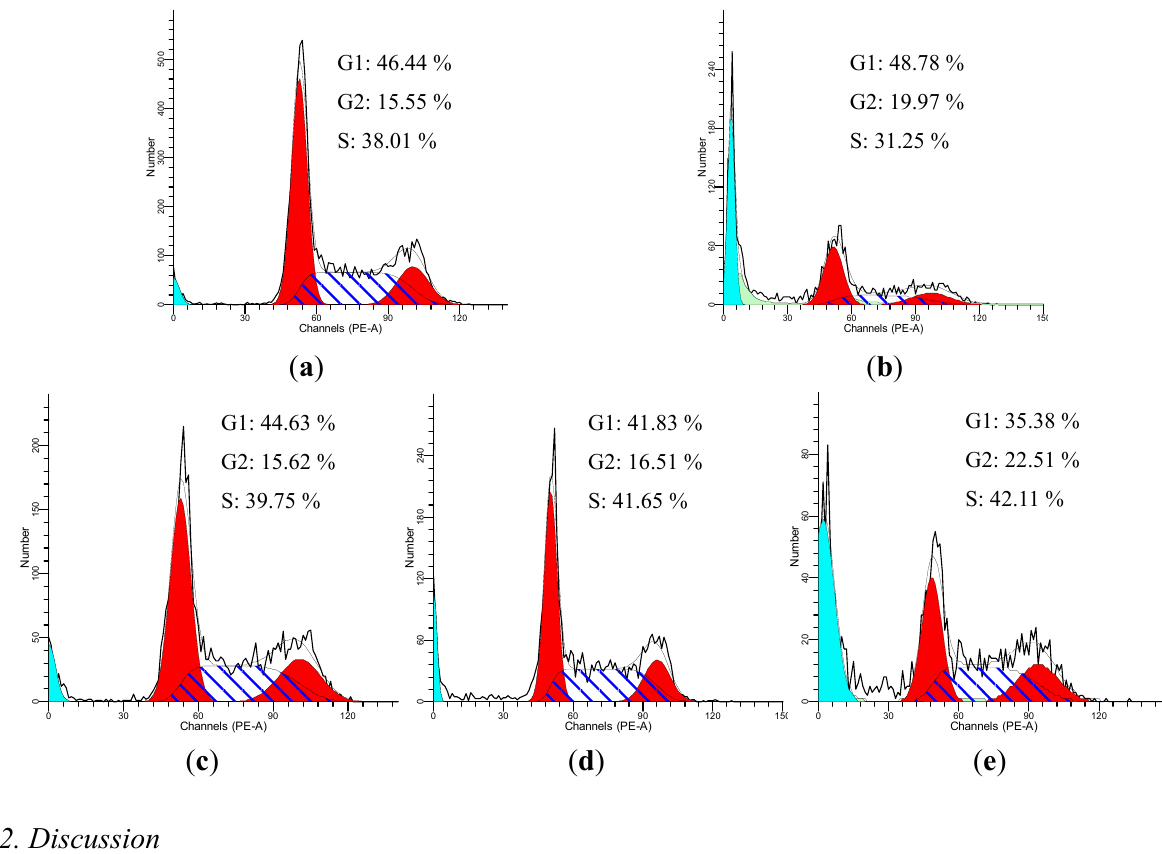
Figure 6. cis - Z,Z' -3a.7a',7a.3 a'-Dihydroxyligustilide effectively relieves H cycle arrest. Treatment with compound 1 led to a decrease in G2 phase and increase in S phase. ( a ) control cells; ( b ) model cells; ( c – e ): cells treated with 100, 50, 25 μ mol/L of endo- Z,Z' -3a.7a',7a.3a'-diligustilide,